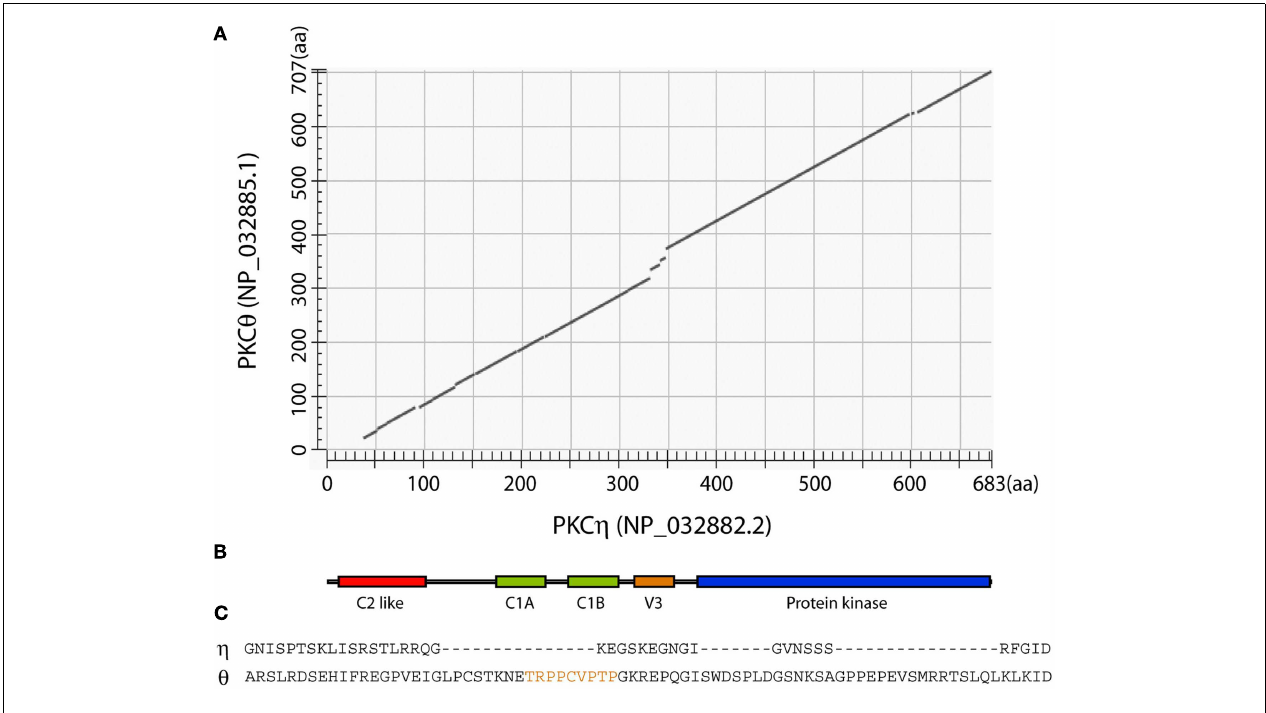
to both PKC η and PKC θ proteins. (C) Alignment of PKC η and PKC θ V3 domains.The region identified as important for PKC θ interaction with CD28 (Kong et al., 2011) is highlighted in